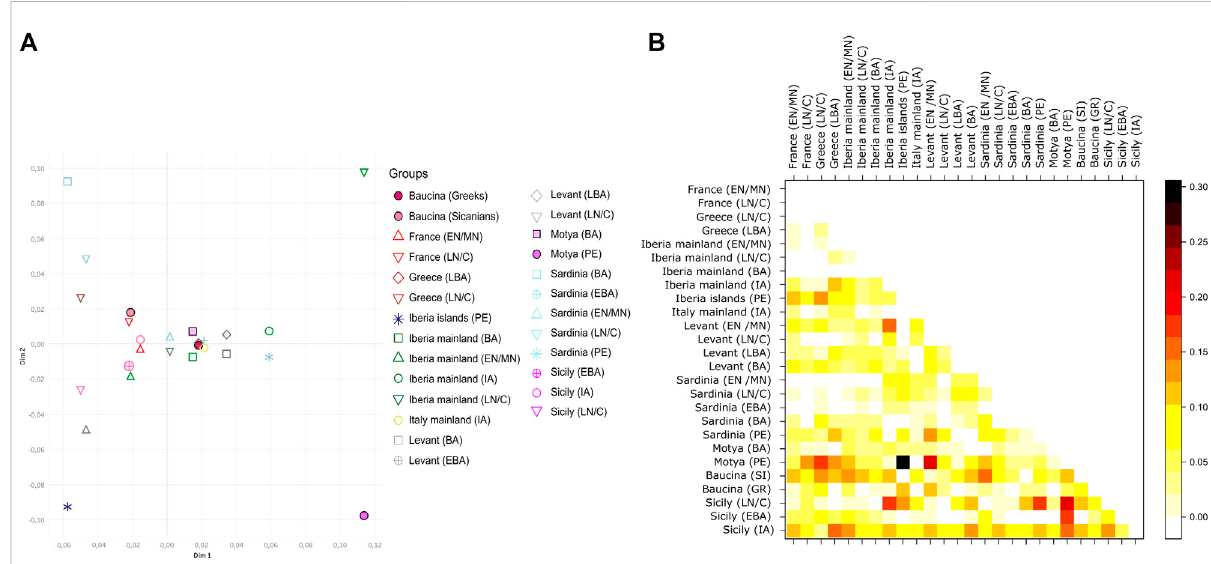
FIGURE 4 Pattern of similarities with populations of Mediterranean. (A) Multidimensional Scaling (MDS) based on a matrix of molecular distances (FST) among groups; geographical population are indicated with different colors, while cultures are indicated with different symbols. (B) Heatmap describing a matrix of molecular distances (FST) among groups, each group is indicated by a number. Cultures are labelled as follow: EN/MN = Early/Middle Neolithic, LN/C= Late Neolithic/Chalcolithic, BA = Bronze Age, EBA = Early Bronze Age, LBA = Late Bronze Age, IA = Iron Age, PE = Phoenicians, SI = Sicanians and GR =